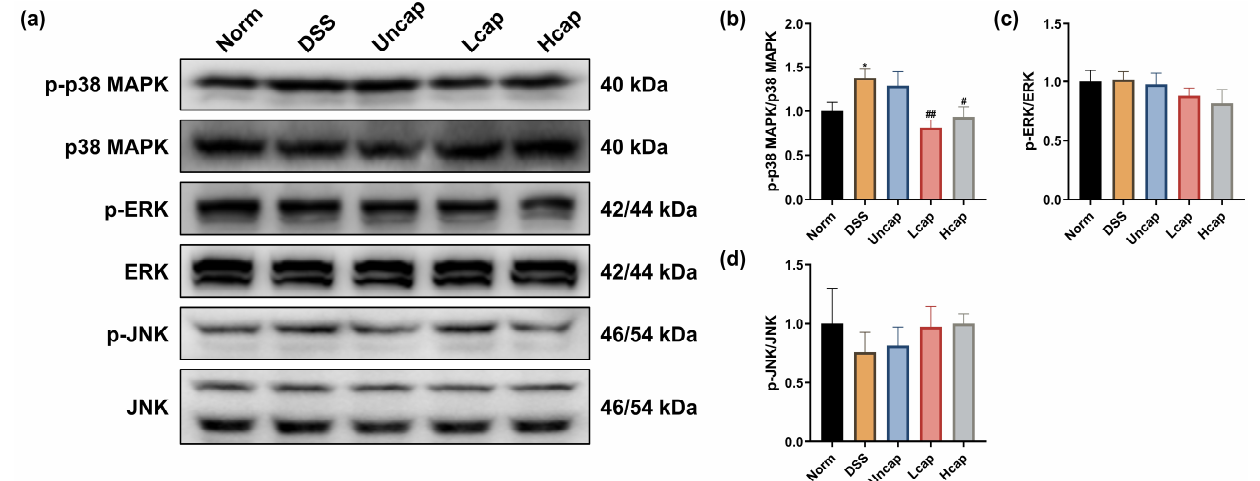
Figure 7. S. spongiosa polysaccharides modulate the MAPK/ERK pathway in colitis mice. ( a ) The protein abundances of p-p38 MAPK, p38 MAPK, p-ERK, ERK, p-JNK and JNK were estimated by Western blotting analysis. ( b ) The normalization of p-p38 MAPK to p38 MAPK. ( c ) The normalization of p-ERK to ERK. ( d ) The normalization of p-JNK to JNK. The values are reported as means ± SD ( n = 8). * p < 0.05 vs. Norm group; # p < 0.05 and ## p < 0.01 vs. DSS group.